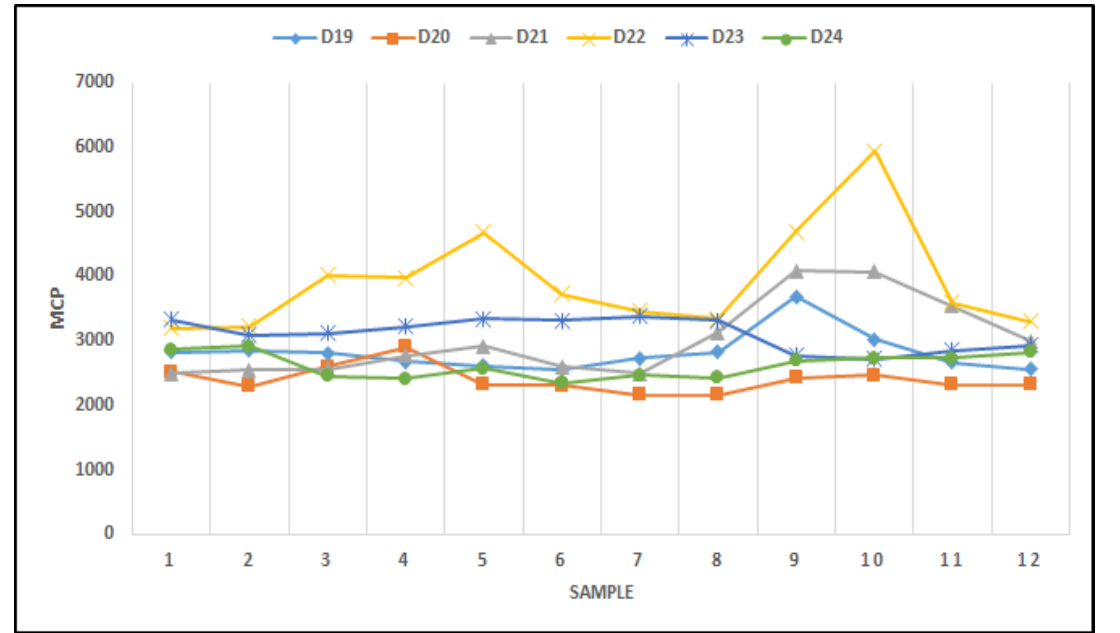
Figure 4. Data samples for evaluation of the performance of proposed cubic grey model